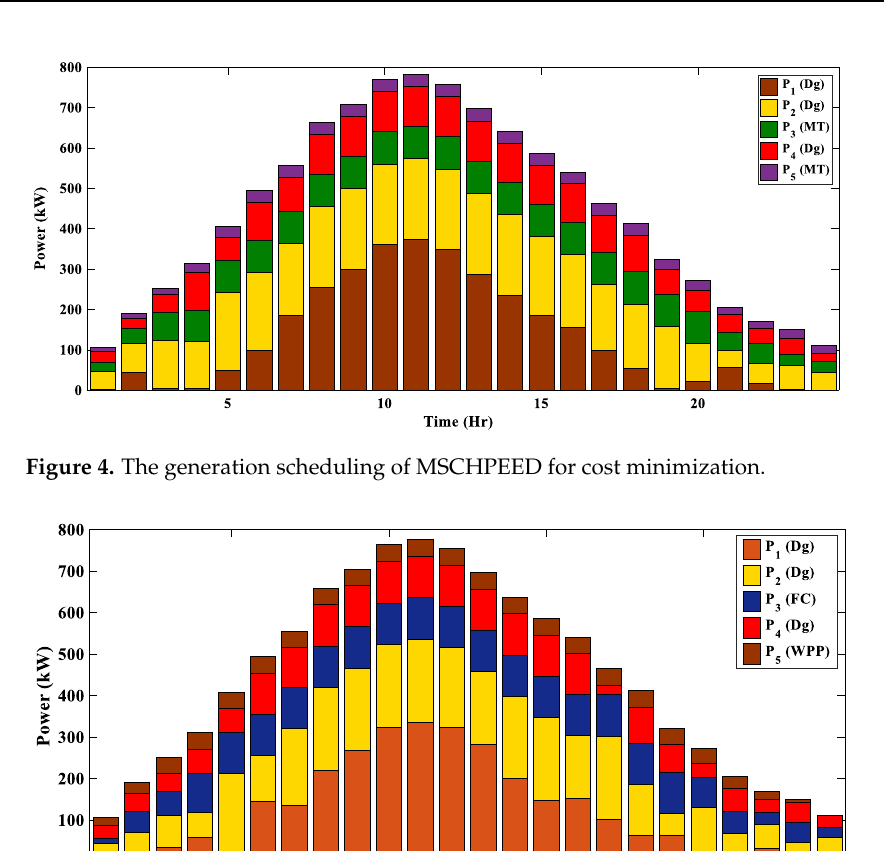
Figure 6. The generation scheduling of MSCHPEED for emission minimization.